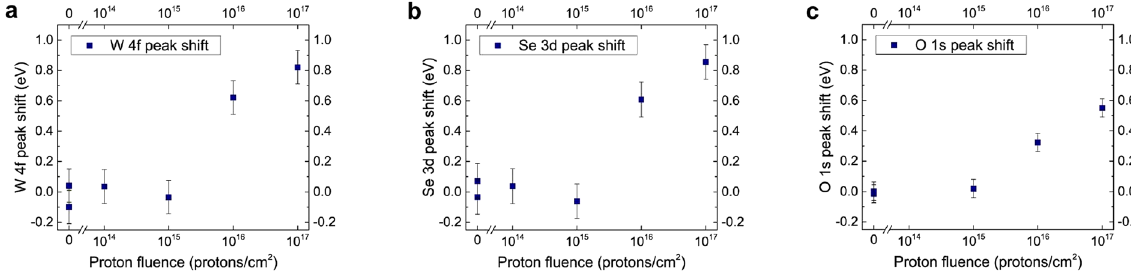
Figure 1. Binding energy shifts of WSe 2 /SiC heterostructure as a function of proton fluence. The shift of the peak position of ( a ) W 4 f 7/2 (~32 eV) and ( b ) Se 3d 5/2 (~54 eV) corresponding to the WSe 2 . ( c ) The binding energy shift of O 1 s peak (~532 eV) from surface oxygen. Data points at zero fluence correspond to control samples. A fluence at or above 10 16 protons/cm 2 is shown to induce a detectable shift in the XPS